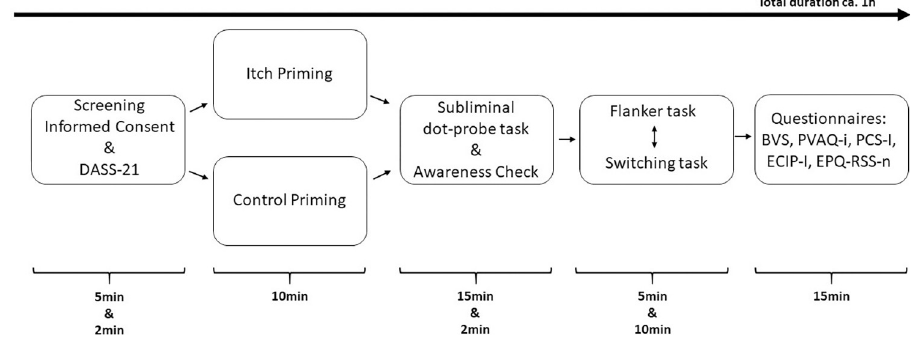
Fig 1. Study design. Overview of the procedure during the lab session. Note : DASS-21 = Depression, Anxiety, and Stress Scale- short form; BVS = Body Vigilance Scale; PVAQ = Pain Vigilance and Awareness Questionnaire -adjusted for itch; PCS = Pain Catastrophizing Scale -adjusted for itch; ECIP = Experience of Cognitive Intrusions of Pain Scale -adjusted for itch; EPQ-RSS = Neuroticism Scale of Eysenck Personality Questionnaire–revised short form.